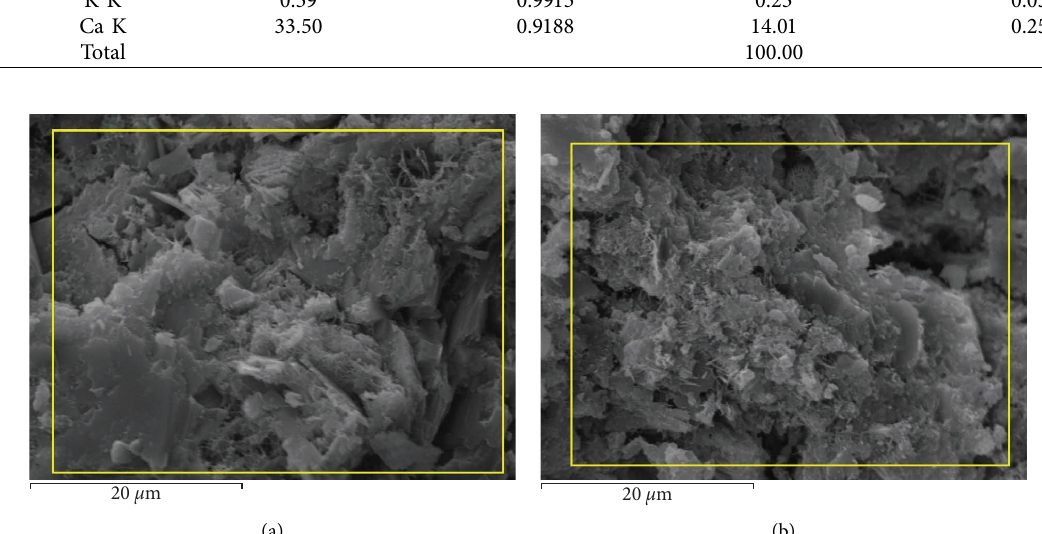
Figure 14: ARGFRC EDS whole surface observation (magnifed 6000 times): (a) EDS-FC0 and (b)